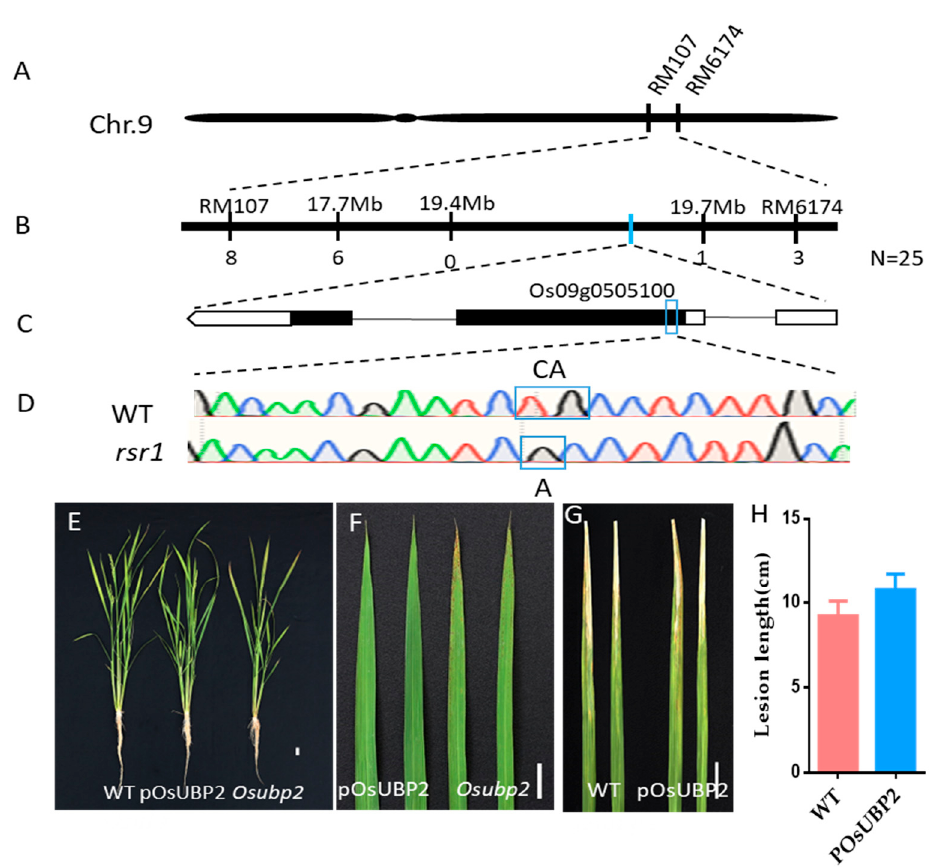
Figure 2. Map-based cloning of OsRSR1 . ( A ) OsRSR1 was initially mapped on chromosome 9 between simple sequence repeat markers RM107 and RM614. ( B ) The OsRSR1 locus was fine-mapped to a 2-Mb genomic region between 17.7 Mb and 19.7 Mb. The numbers under the linkage map represent the number of recombinants, n = 25. ( C ) Structure of OsRSR1 gene and mutation site. The line represents the intron; black boxes represent the exons; white boxes represent 3 ′ UTR (left) and 5 ′ UTR (right); the blue box represents the mutation site. ( D ) The sequence of the mutation site in WT and rsr1 mutant, the rsr1 mutant missing a base C compared with WT cased frameshift mutation. ( E ) The phenotype of 2-month-old WT, Osubp2 mutant and pOsUBP2 T2 plants. T2: T2 generation of the pOsUBP2 transgenic plants (after selfing). ( F ) Leaves (second from the top) of pOsUBP2 T2 plants and Osubp2 mutant at 60 days post-sowing (dps). ( G ) Leaves of WT and pOsUBP2 T2 plants were inoculated with compatible Xoo isolate P6. Leaves were photographed at 7 dpi. Scale Bar = 2 cm. ( H ) Lesion length on the leaves of WT and complement pOsUBP2 T2 plants at 7 dpi shown in ( G ). Error bars represent + SD ( n = 9).